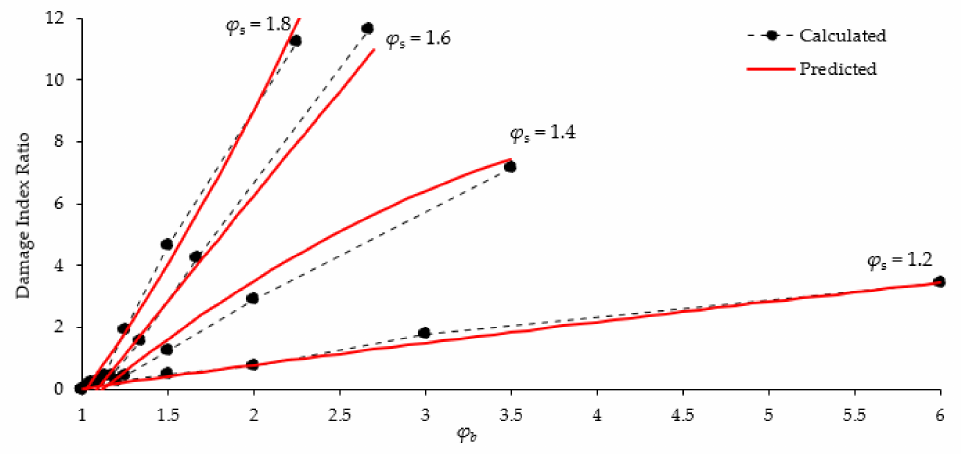
Figure 18. DI ratio with different ϕ s and ϕ b for stepped model.